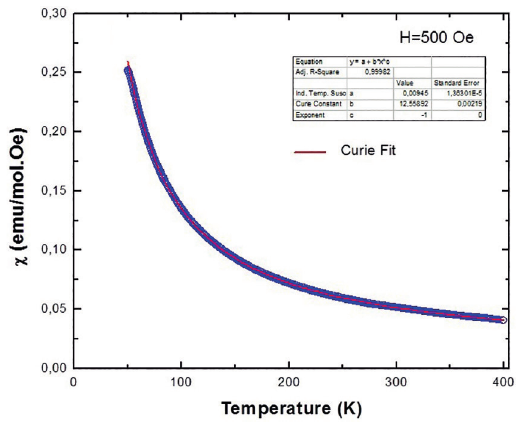
Figure 3: DC magnetic susceptibility as a function of temperature for SHNO (data points) and Curie fitting of the paramagnetic characteristic (line).